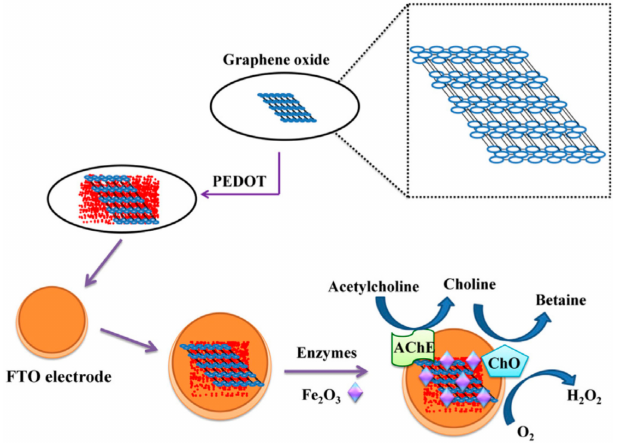
Figure 6. The modification process of PEDOT-based acetylcholine sensor. Reprinted with permission from [59].